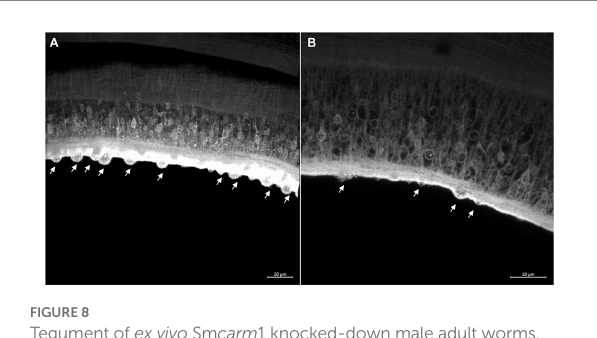
FIGURE 8 Tegument of ex vivo Sm carm 1 knocked-down male adult worms. Morphological changes in the tegument of male adult worms recovered from mice infected with schistosomula from (A) negative control (De Andrade et al., 2014) and (B) Sm carm 1-dsRNA. The arrows indicate the tubercles in the tegument and the white bars indicate the scale 20 μ m.